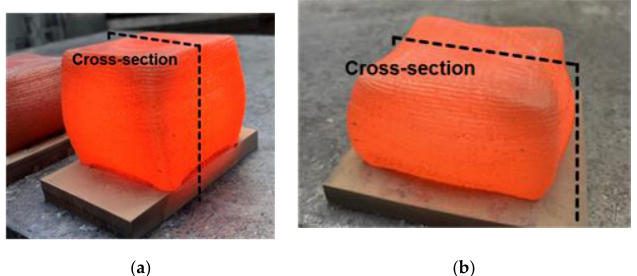
Figure 2. ( a ) L-DED built sample after hot forging at a temperature of 930 °C, deformed to about 25% compression (cross-section Figure 4d indicated), ( b ) L-DED built sample after hot forging at ~930 °C, deformed to about 50% compression (cross-section Figure 4e indicated). Table 3. Applied thermomechanical treatments after L-DED manufacturing.